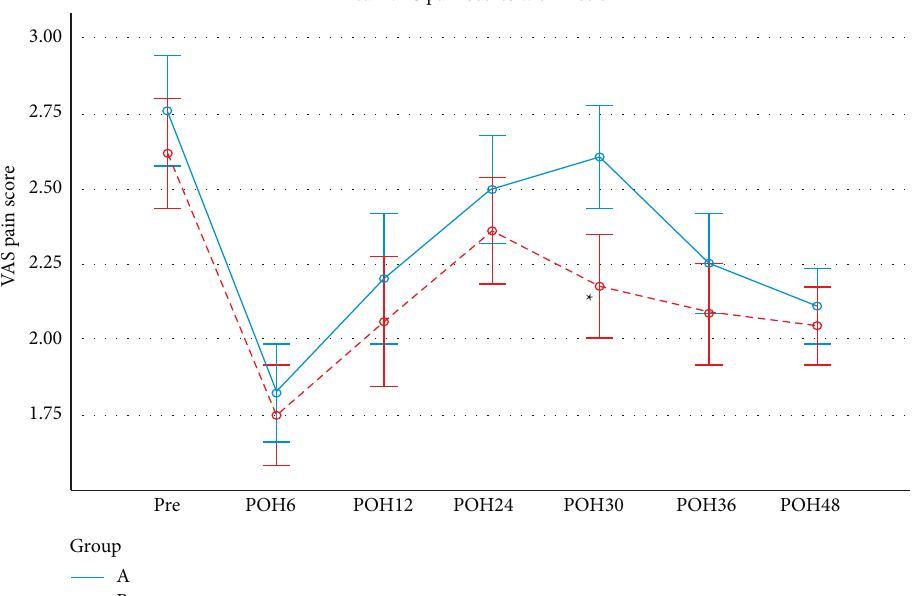
Figure 2: Mean Visual Analogue Scale (VAS) pain scores with motion before operation (Pre) and at postoperative hours (POH), ∗ P < 0 . 001.